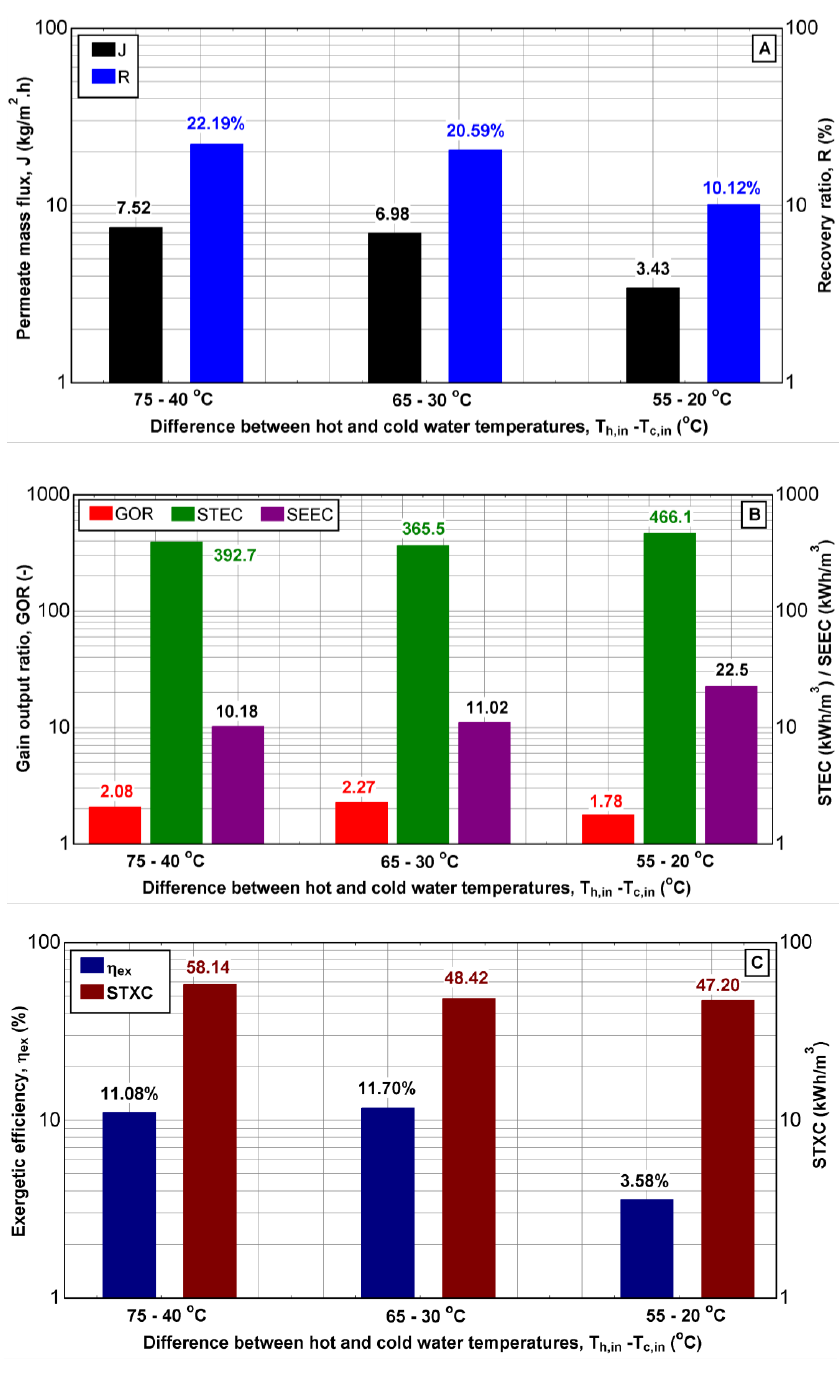
Figure 15. Effect of the difference between hot and cold water temperatures on ( A ) permeate flux and recovery ratio, ( B ) gain output ratio, specific thermal energy consumption, and specific electrical energy consumption, ( C ) exergetic efficiency, and specific thermal exergy consumption ( 𝑉̇ ℎ = 840 L/h, 𝑉̇ 𝑐 = 405 L/h, 𝑉̇ 𝑓 = 87 L/h, T f , in = 25 °C, w = 1260 ppm, and P a , vac = 115 mbar).